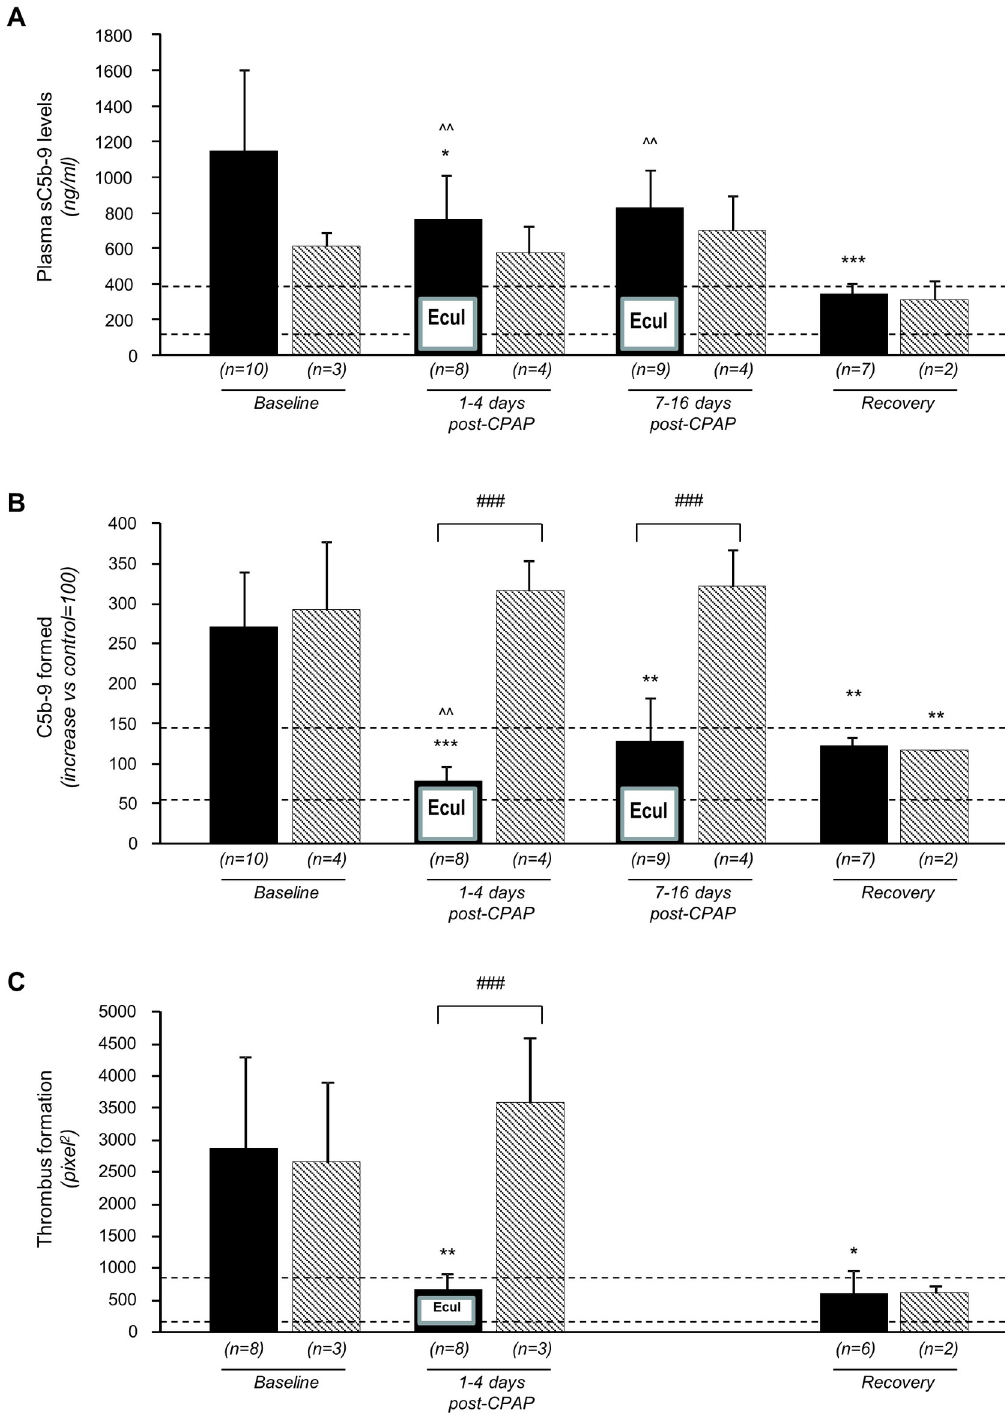
Fig 2. Changes in sC5b-9 plasma levels and in ex vivo serum induced C5b-9 and thrombus formation on HMEC-1 lines in eculizumab-treated patients and “biochemical” controls. SC5b-9 plasma levels (A), ex vivo serum induced C5b-9 (B) and thrombus formation on HMEC-1 lines (C) at baseline, at 1–4 days and 7–16 days of CPAP ventilator support and at post discharge recovery visit in eculizumab-treated patients (Black columns) and “biochemical” controls (diagonal stripes), respectively. Numbers under the columns describe the number of eculizumab—treated patients or controls evaluated at each time-point. Horizontal dashed lines are the upper and lower limit of normal range (mean ± 2SD) of each considered